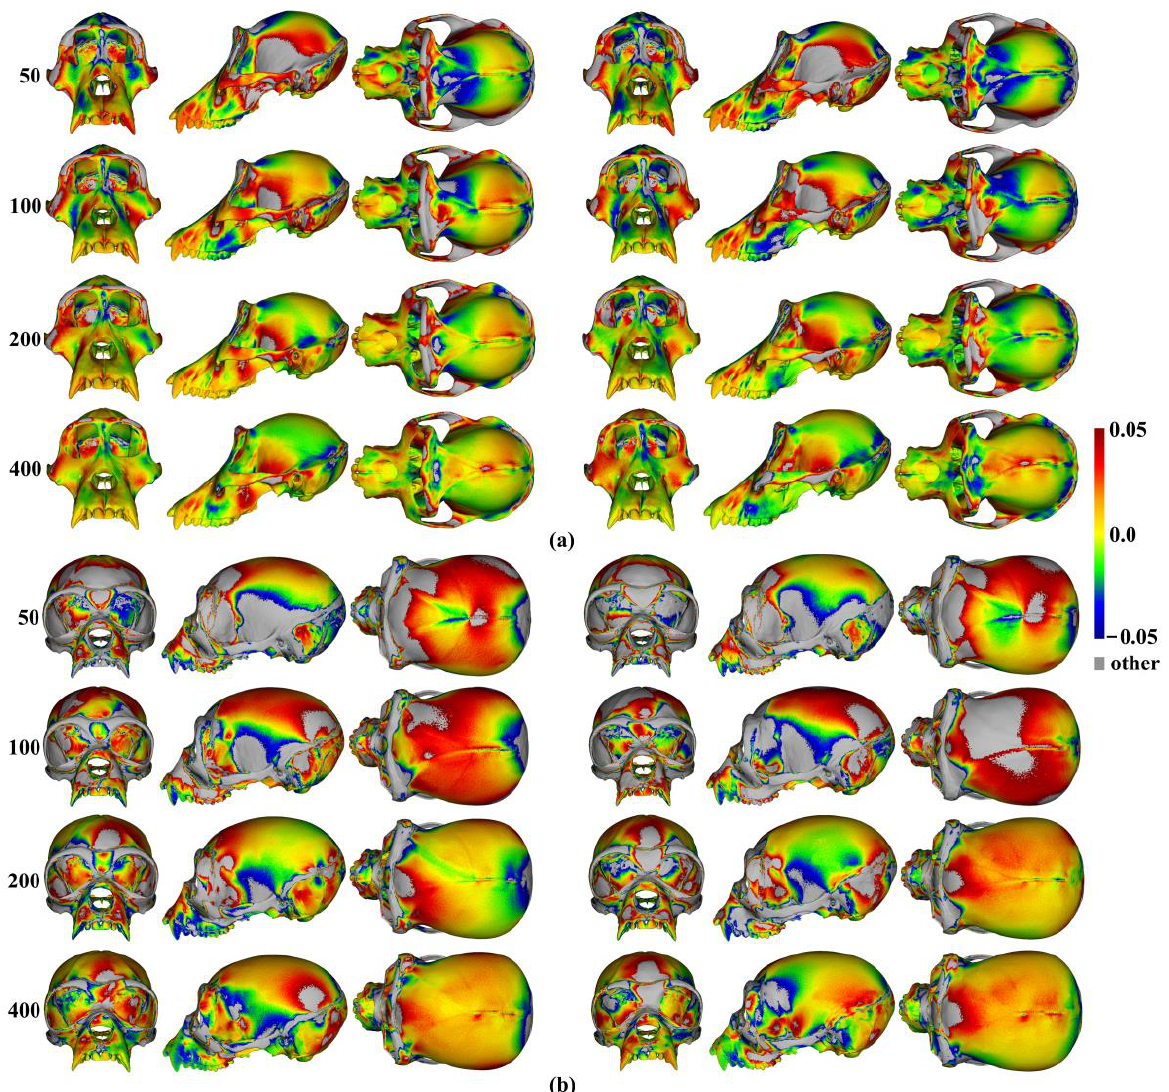
Figure 22. Colour map of local area differences computed between the re-semilandmarked and re-warped allometric predictions of surfaces of ape crania at the ( a ) maximum and ( b ) minimum sample centroid sizes, computed between lower densities (reference) and the maximum density (target) of semilandmarking. Left: sliding TPS; right: TPS&NICP. Scale bar indicates difference in local area between reference and target surfaces expressed as a proportion of the reference area.